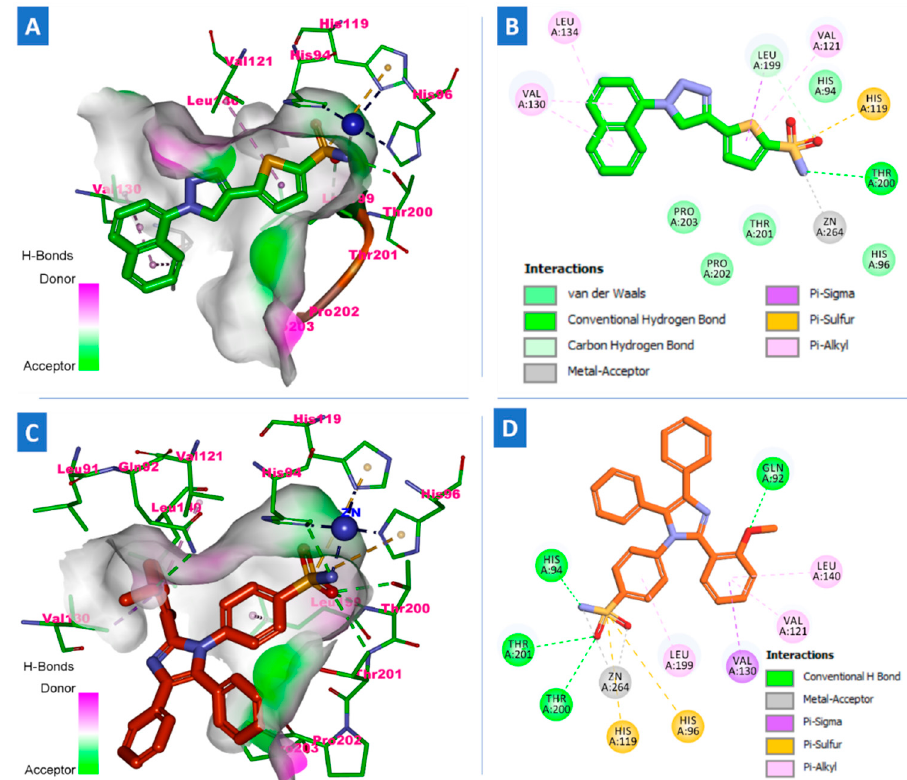
Figure 3. Comparison of docking and 2/3D binding modes of compound 5g (stick with carbons colored in orange) and co-crystallized inhibitor 9FK (stick with carbons colored in green) within the catalytic active site of CA-IX isoenzyme (PDB code: 5FL4); ( A ) 3D binding mode of the co-crystallized ligand 9FK into active site of CA-IX isoenzyme; ( B ) 2D docking mode of 9FK showing different types of interactions inside the active site of CA-IX isoenzyme; ( C ) 3D binding mode of compound 5g into active site of CA-IX isoenzyme; ( D ) 2D docking mode of 5g showing different types of interactions inside the active site of CA-IX isoenzyme. Zn 2+ cation is presented as a blue sphere in coordination with His94, His96, His119 and -NHSO 2 shown in dashed dark blue lines. H-bonds are represented as dashed green lines. All hydrogens were removed for the purpose of clarity.